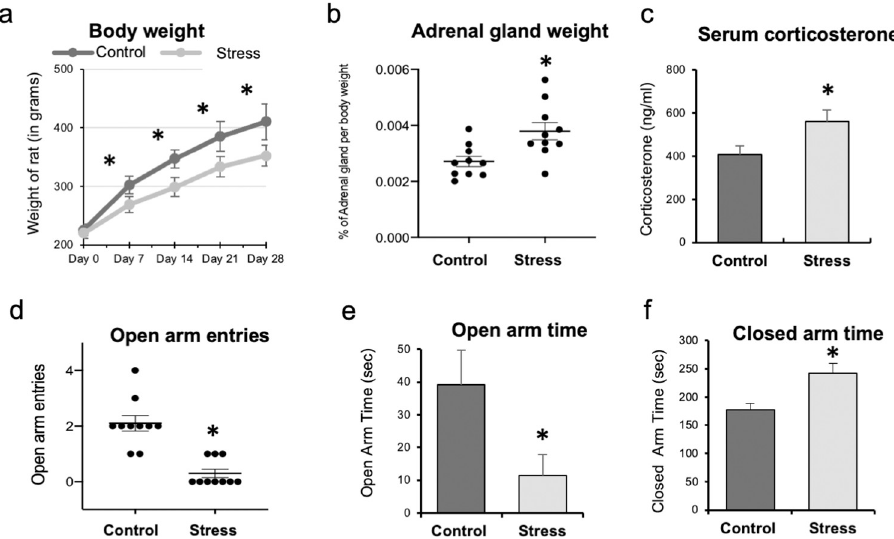
Fig 1. The results of the different stress markers. (a) From the first to fourth week of the experiments, the mean body weights of the rats in the stress group were significantly lower than those in the control group when compared at same time point ( � p < 0.001; Mann Whitney-U test). (b) The mean weight of the adrenal gland per body weight were significantly higher in the stress group than in the control group ( � p = 0.005; Mann Whitney-U test). (c) The serum corticosterone level after 1 month of the chronic stress protocol was significantly higher in the stress group compared to that in the control group ( � p < 0.001; Mann Whitney-U test). (d, e, f) The graphs show the results of behavior analysis of rats using elevated plus maze test. The rats were placed at the center of the maze facing the open arm and allowed to explore it for 10 min. The number of entries and the time spent in the open and closed arms by each rat were recorded manually. (d, e) The number of open arm entries and the time spent in the open arm were significantly lower in the stress group compared to those in the control group ( � p < 0.001 and � p = 0.01, respectively; Mann Whitney-U test). (f) The time spent in the closed arm was significantly higher in the stress group as compared to that in the control group ( � p = 0.007; Mann Whitney-U test).